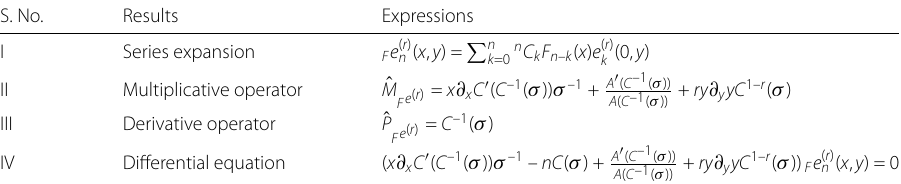
Table 6 Results for Boas–Buck-truncated exponential polynomials F e ( r ) n ( x , y ) S.